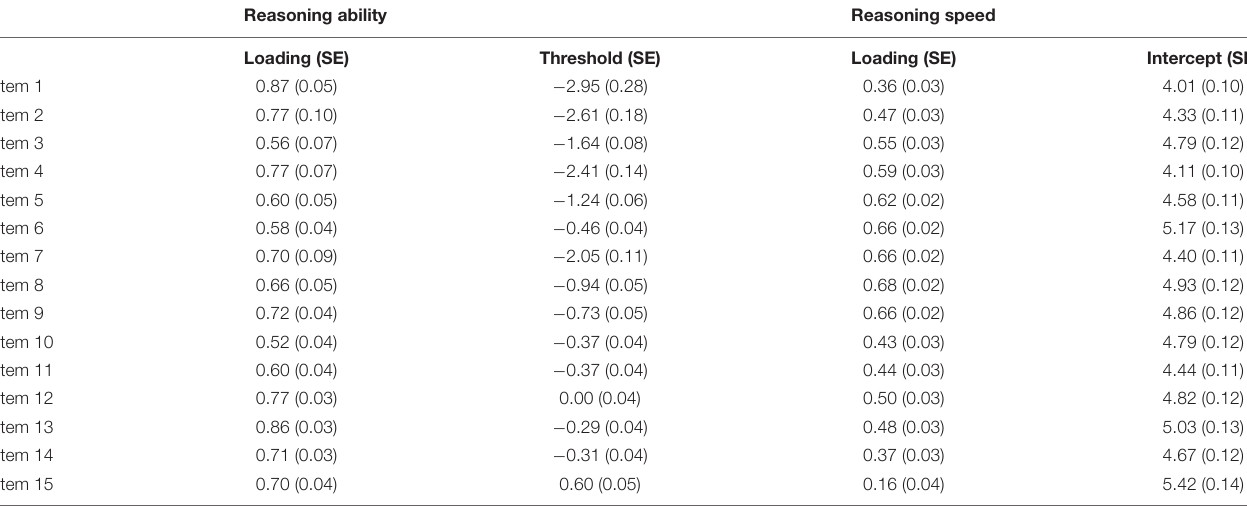
TABLE A2 | Measurement models reasoning (standardized results).